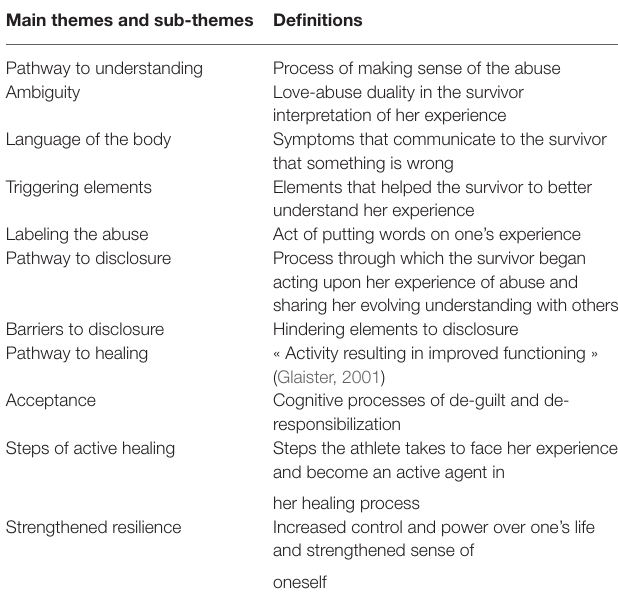
TABLE 1 | Athlete’s narrative on sexual abuse in